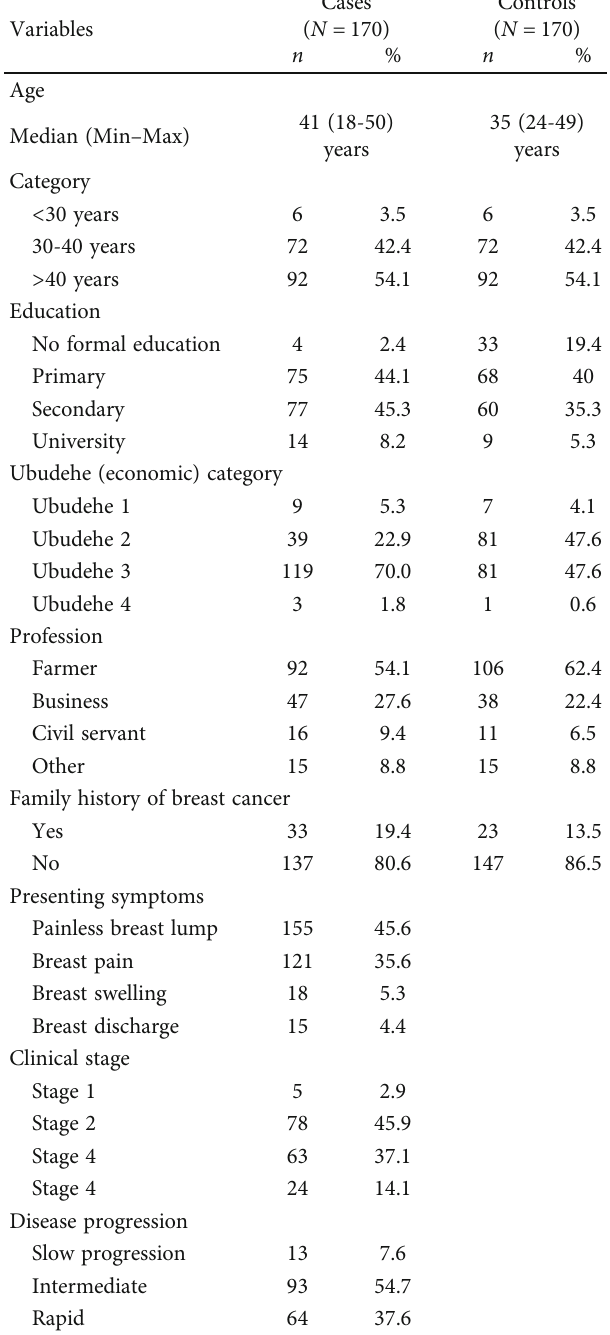
Table 1: Sociodemographic and clinical characteristics of study participants (cases and controls, N = 340